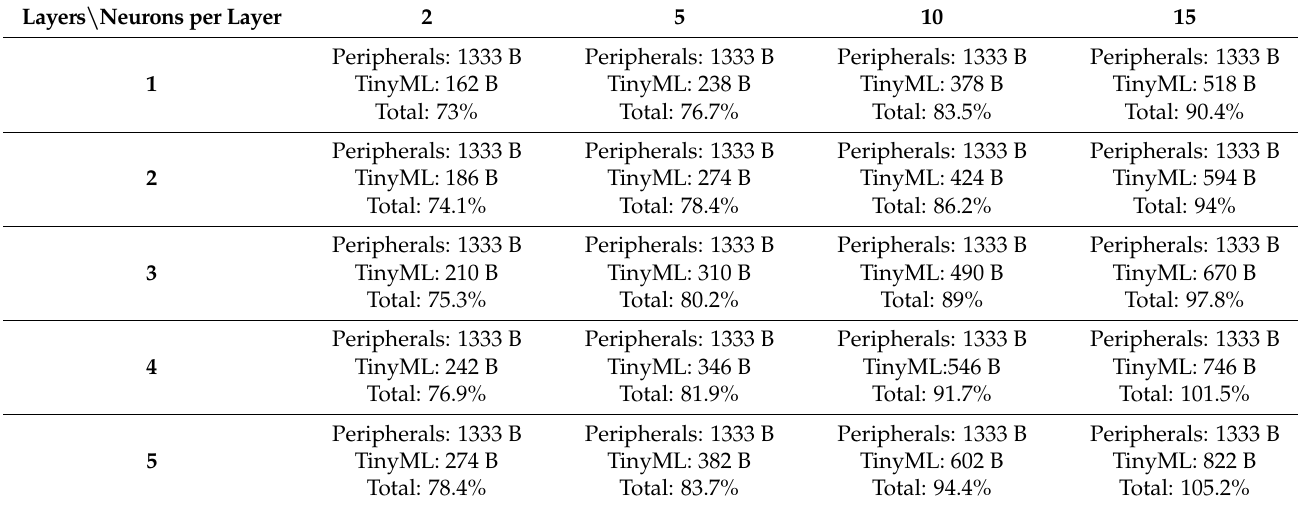
Table 3. SRAM footprint on the wearable